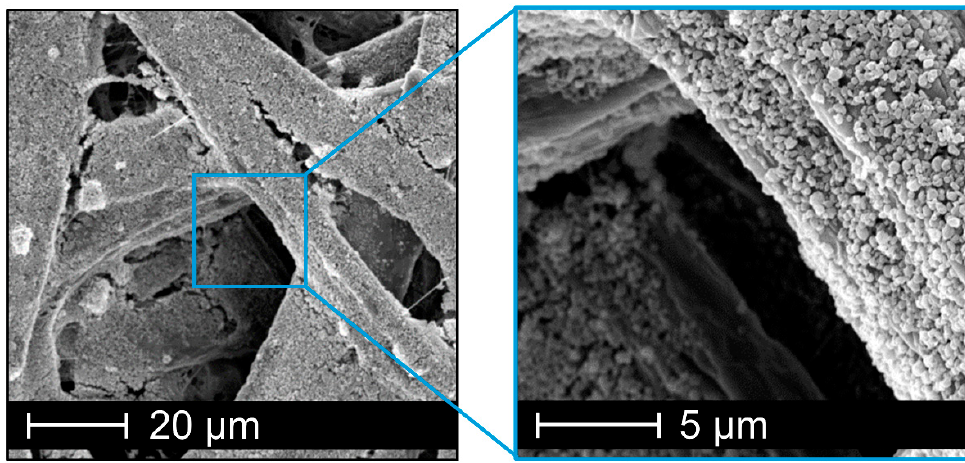
Figure 8. SEM images of model paper substrates coated with cellulose acetate nanoparticles with 3 g·m -2 for zone of inhibition test.